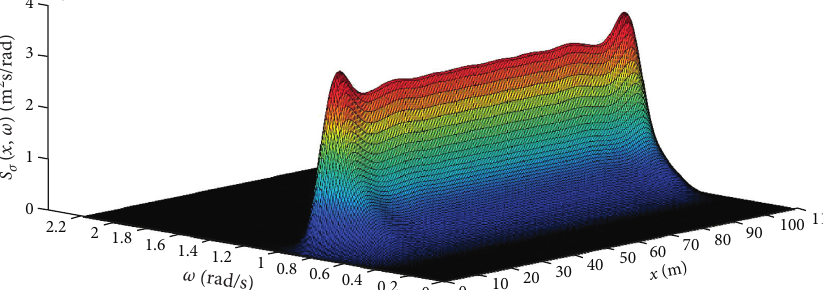
Figure 7: The total stress spectrum ( H